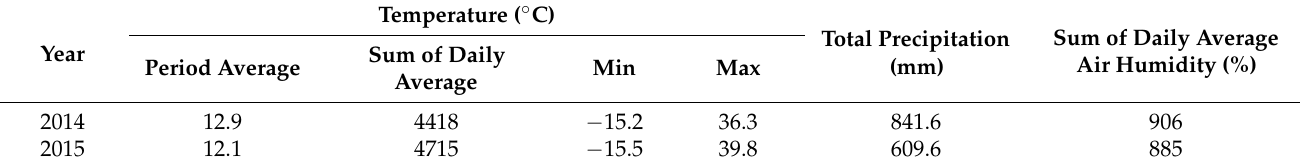
Table 2. The reference information for the climatic parameters (1 January–31 December).